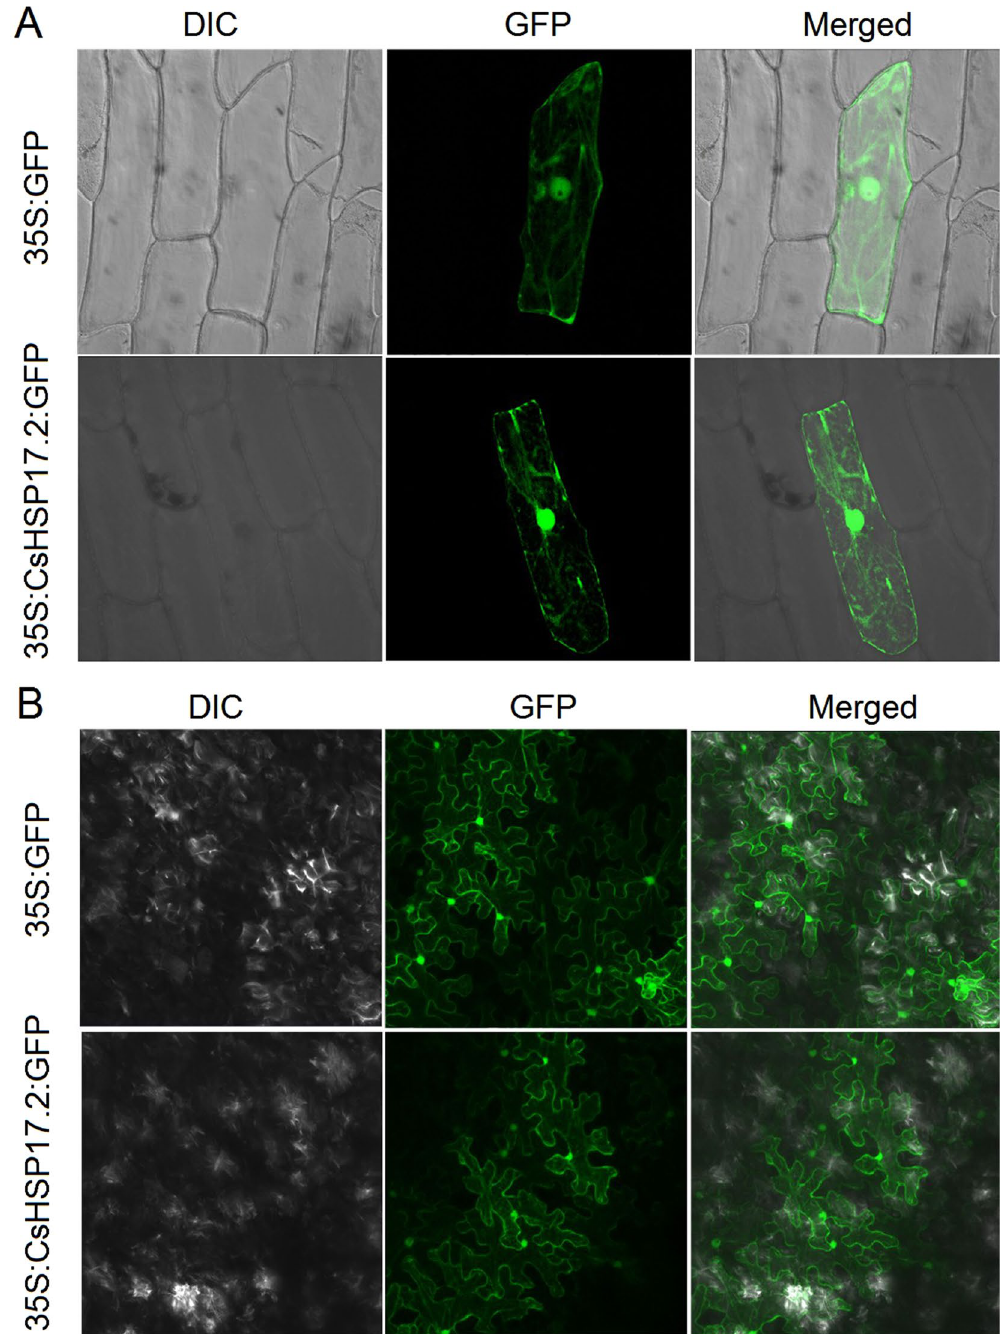
Figure 1. CsHSP17.2 protein accumulates in the nucleus and the cytosol. ( A ) Subcellular localization of CsHSP17.2 in onion ( Allium cepa ) epidermal cells. ( B ) Subcellular localization of CsHSP17.2 in tobacco ( Nicotiana benthamiana ) leaves. 35S:GFP indicates the vector control, and 35S:CsHSP17.2:GFP refers to the target Constitutive expression of CsHSP17.2 confers thermotolerance in transgenic P. pastoris . To confirm that CsHSP17.2 influenced thermotolerance, we examined the expression of CsHSP17.2 in a eukaryotic organism. First, RT-PCR was used to verify that the recombinant plasmids were present in the transformed P. pastoris cells. The amplified fragments were 221 and 548 bp long, which were the expected sizes for the control and CsHSP17.2- overexpressing lines, respectively (Fig. S2b). The positive strains were used for subsequent ther- motolerance assays. Similar growth rates were observed between the control and the CsHSP17.2- overexpressing lines at 30 °C. However, the growth rates were higher for the CsHSP17.2- overexpressing strains than the control